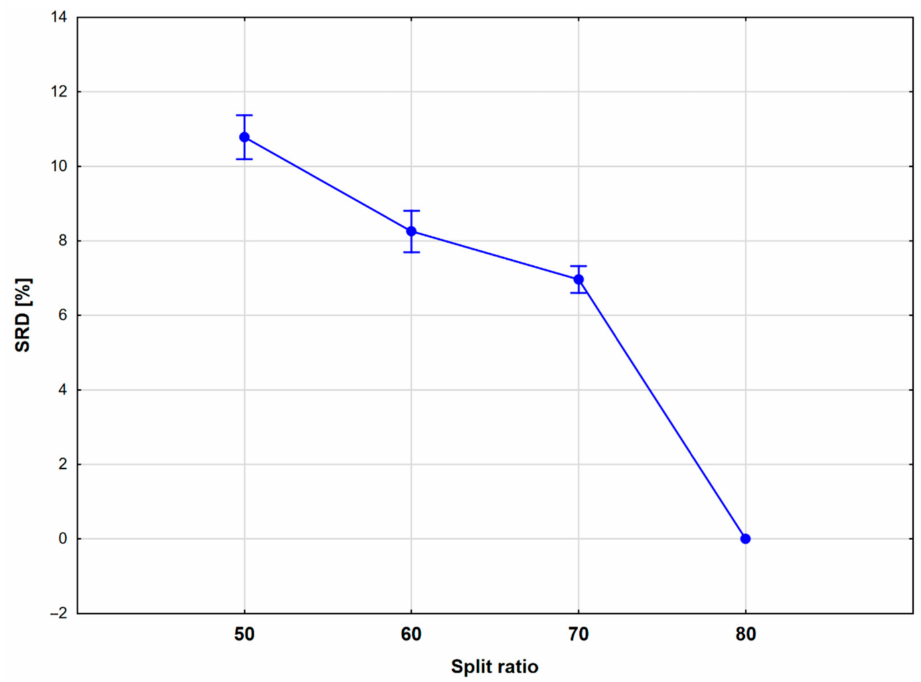
Figure 10. Sum of ranking differences (SRD) (%) values, plotted against the split ratio settings. Average values are marked with blue circles and 95% confidence intervals are also